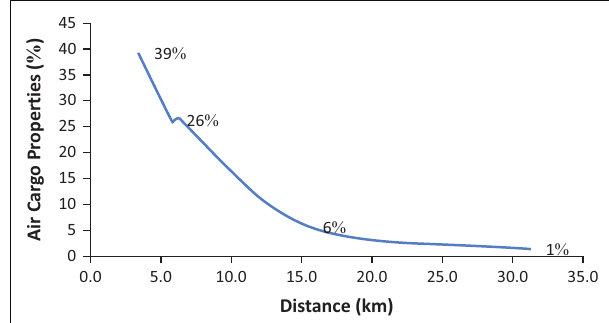
FIGURE 1: Relationship between distance and percentage of air cargo properties.